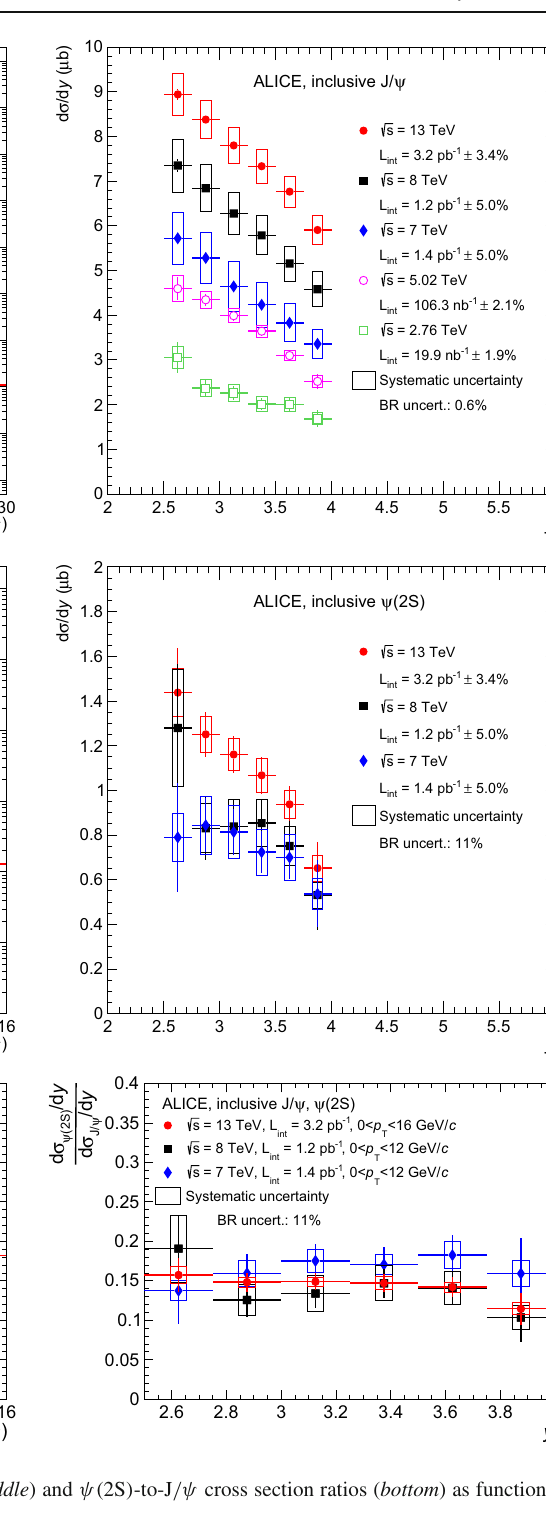
Finally, Fig. 6 shows the J /ψ (left) and ψ( 2S ) (right) p t - and y -integrated inclusive cross sections as a function of measured by ALICE in the y range 2 . 5 < y < 4. For both